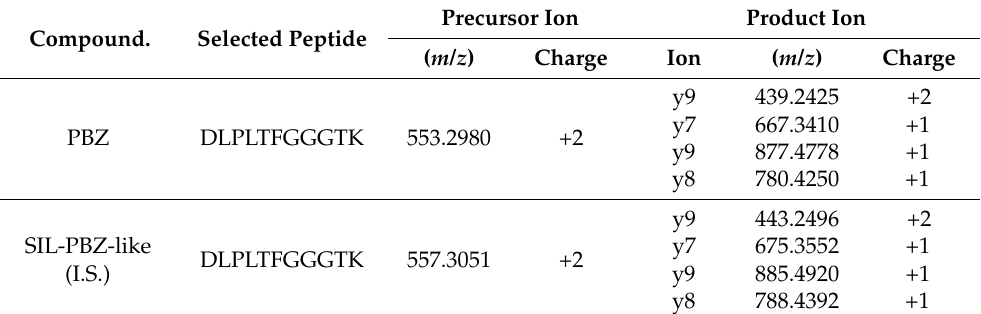
Table 1. LC8 surrogate peptide used for pembrolizumab (PBZ) quantification by LC- MS/HRMS method using the internal standard (SIL-PBZ-like).